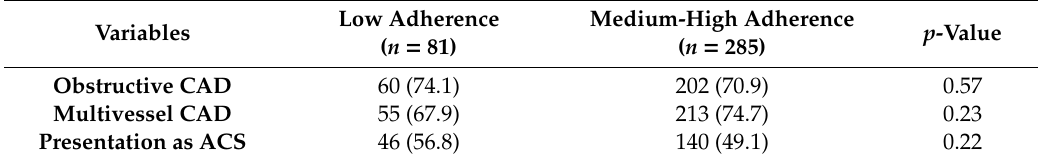
Table 2. Angiographic characteristics of EVA participants, according to the adherence to the Mediterranean